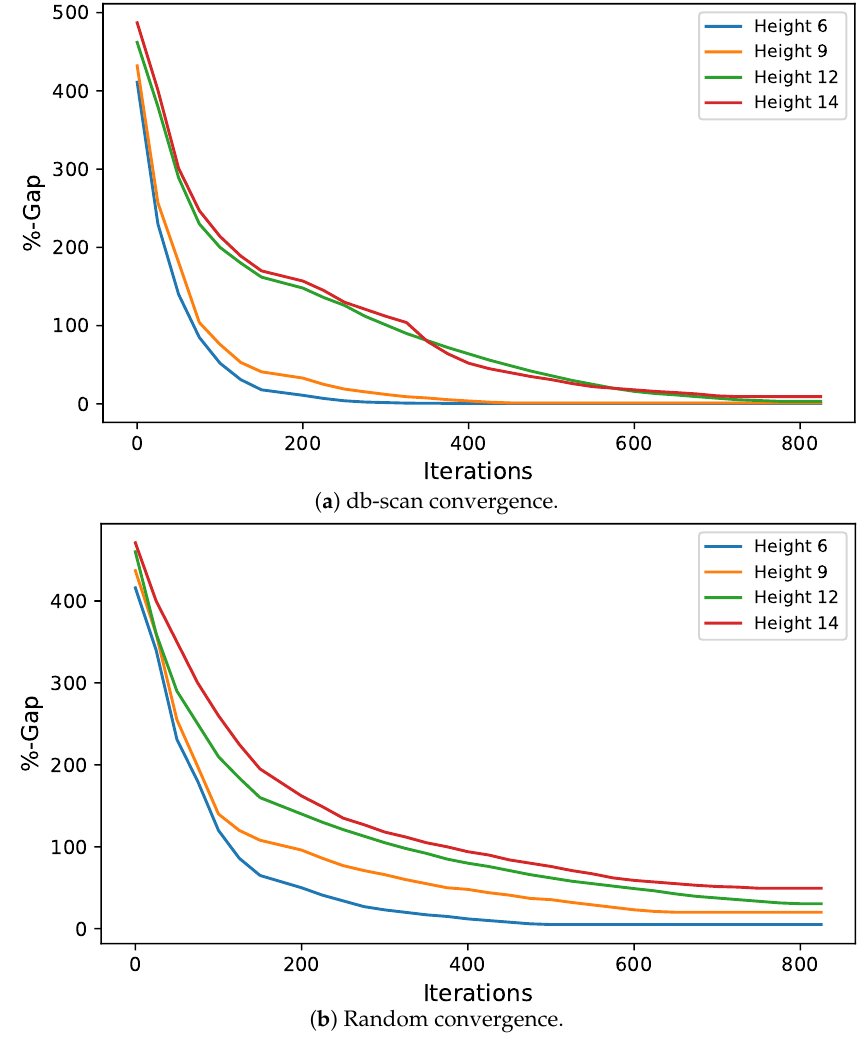
Figure 9. Cost optimization convergence plots for db-scan and random